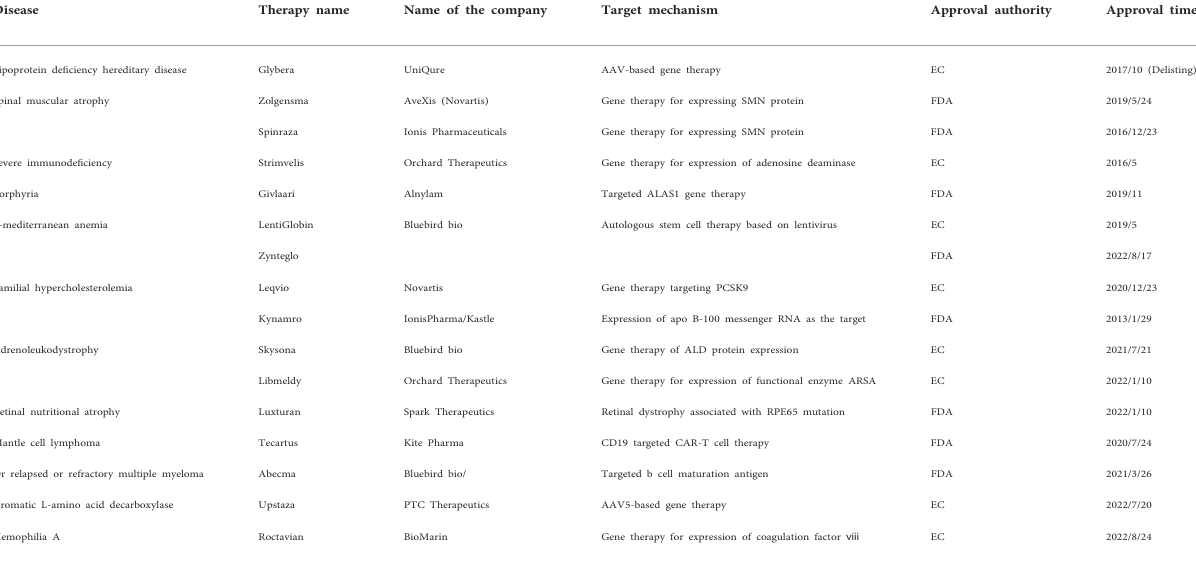
TABLE 1 Marketed genetic drugs in rare diseases. Disease